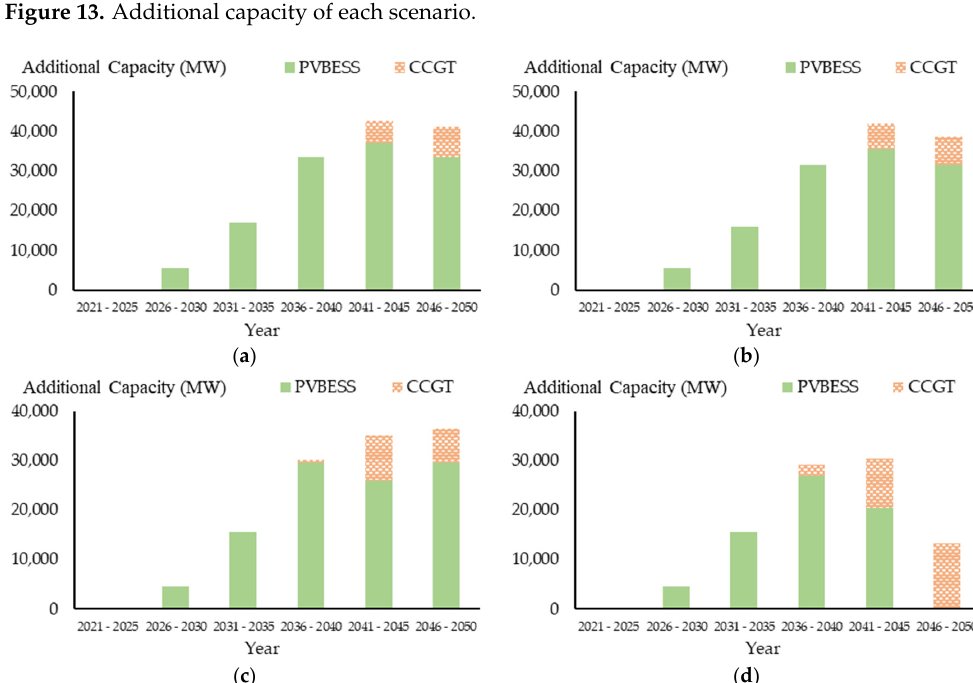
Figure 14. Additional capacity of candidate units in each scenario. ( a ) 0% hydrogen; ( b ) 25% hydrogen; ( c ) 50% hydrogen; ( d ) 75% hydrogen.